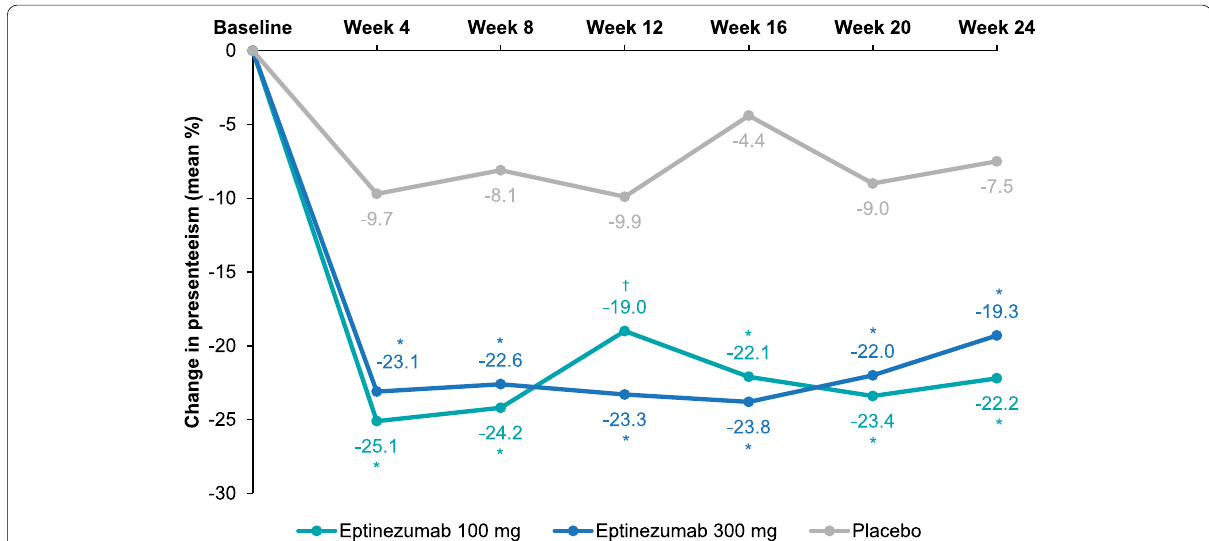
Fig. 2 Mean Changes From Baseline in WPAI:M Presenteeism Subscores. Mean changes from baseline were calculated using LSMeans from a mixed model for repeated measures. The model included the following fixed effects: visit, country, stratification factor (monthly headache days at baseline: 14/> 14) and treatment as factors, baseline WPAI:M presenteeism subscore as a continuous covariate, baseline score-by-visit interaction, ≤ treatment-by-visit interaction, and stratum by-visit interaction. * P < 0.0001 vs placebo; † P < 0.001 vs placebo. WPAI:M, Work Productivity and Activity